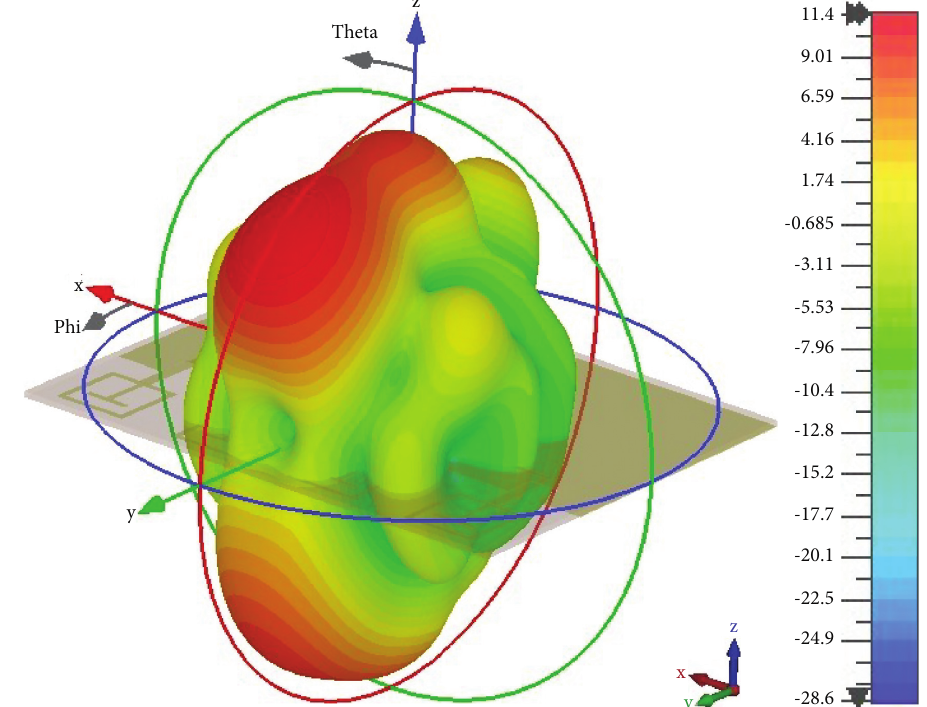
Figure 11: 3D radiation pattern at 28